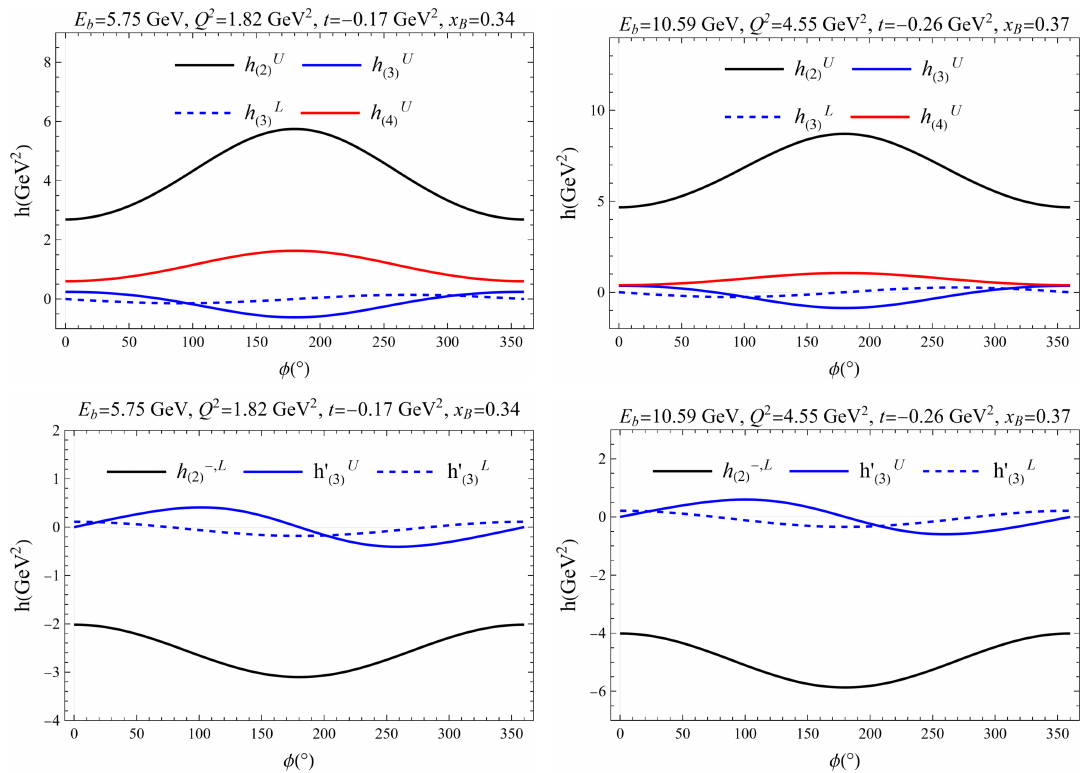
, h U / L and h U , and h − , L and h 0 U / L at typical JLab (2) (4) (3) (2) (3) and h − , L as (2) (2)